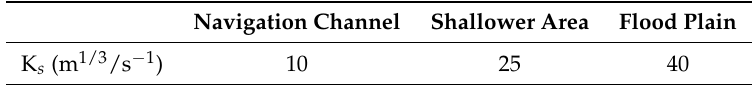
Figure 4. Distribution of the sediment along the SPC and CC. Table 1. Distribution of the Strickler bed roughness coefficient K s along the creeks.